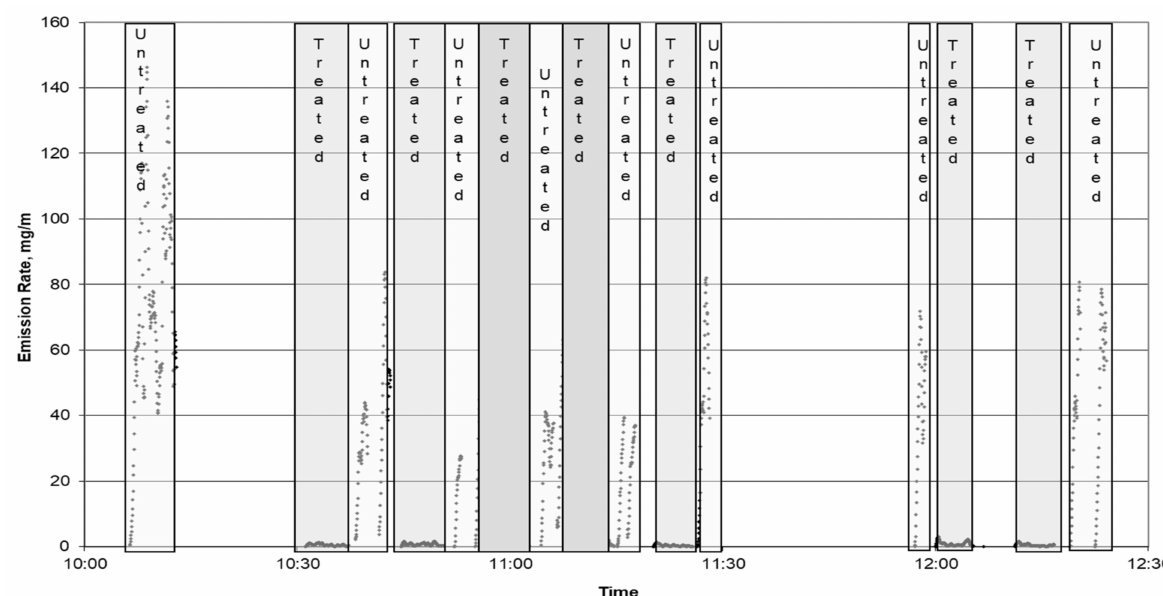
Figure 4. Map of the test segments used on SR288.